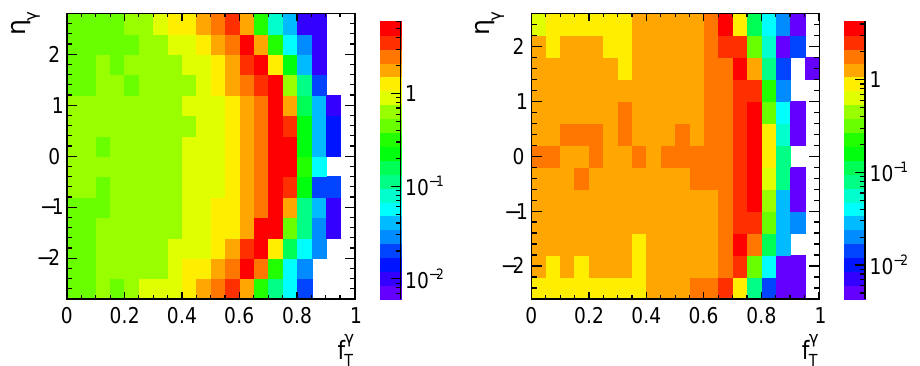
γ , η γ ) plane for T = 400 GeV at Y